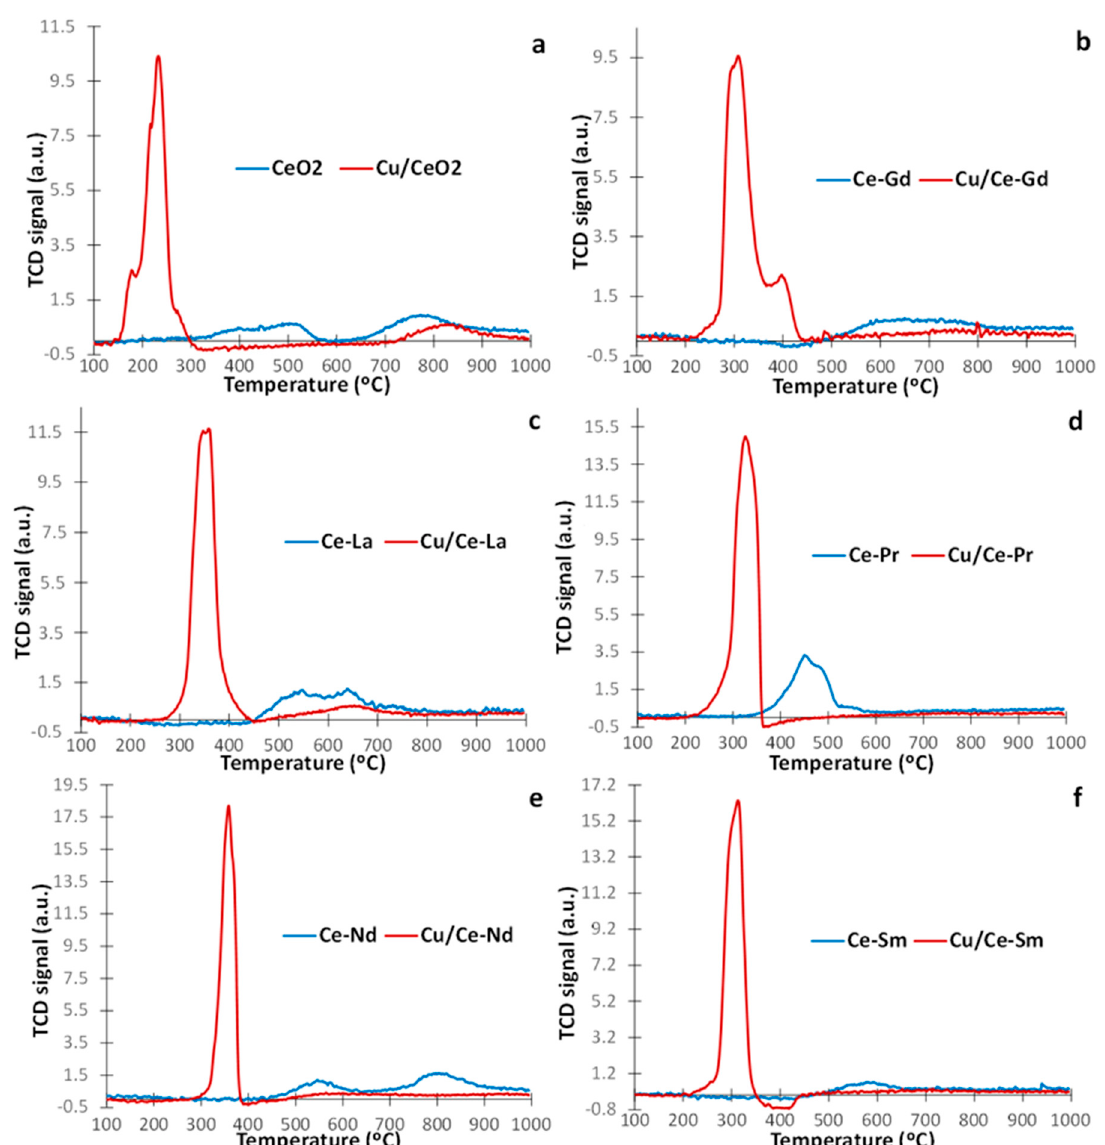
Figure 2. TPR profiles of samples with and without Cu: CeO 2 ( a ); Ce-Gd ( b ); Ce-La ( c ); Ce-Pr ( d ); Ce-Nd ( e ) and Ce-Sm ( f